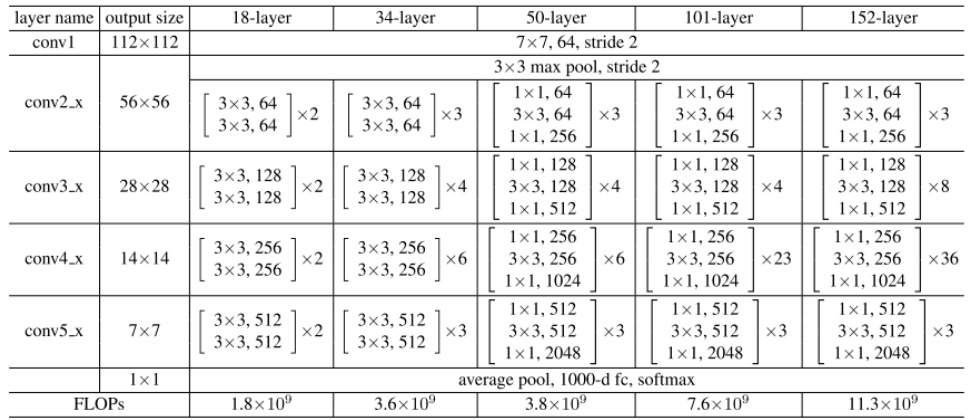
Figure 8. Residual Network architectures used in the development (extracted from [26]). The smaller ResNet-18 is the one showing better results and can perform in real time.